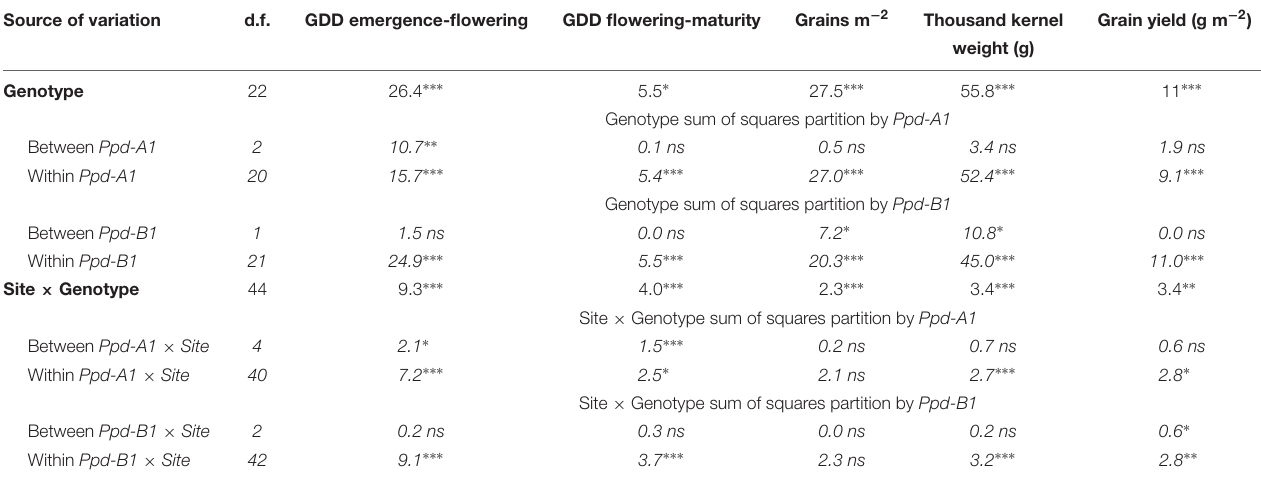
TABLE 3 | Percentage of the genotype sums of squares from the ANOVA partitioned in differences between allelic variants at Ppd-A1 and Ppd-B1 genes and the differences within genotypes carrying a given allele. Source of